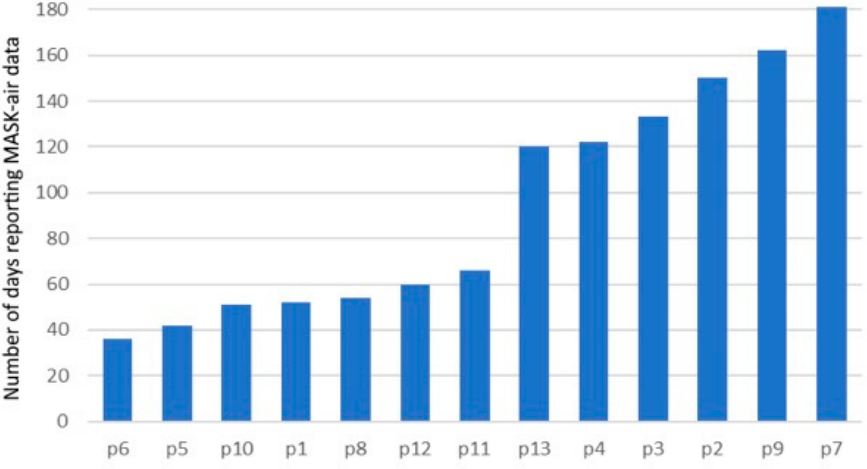
Figure 1. Adherence to the application. The median mMPR was 96.7%, with mMPRs ranging from 60.6% to 100%. Only one Table 1. Demographic characteristics of the patients. patient had an mMPR of lower than 80% (Table 2). The percentage of days for which patients reported only their usual asthma long-acting treatment (with no additional asthma medication) ranged from 48.1% to 100% (median score of 91.8%). Overall, the mMPR displayed a poor correlation with application adherence (Spearman’s rank correlation coefficient of 0.132). Table 2. Frequency of medication